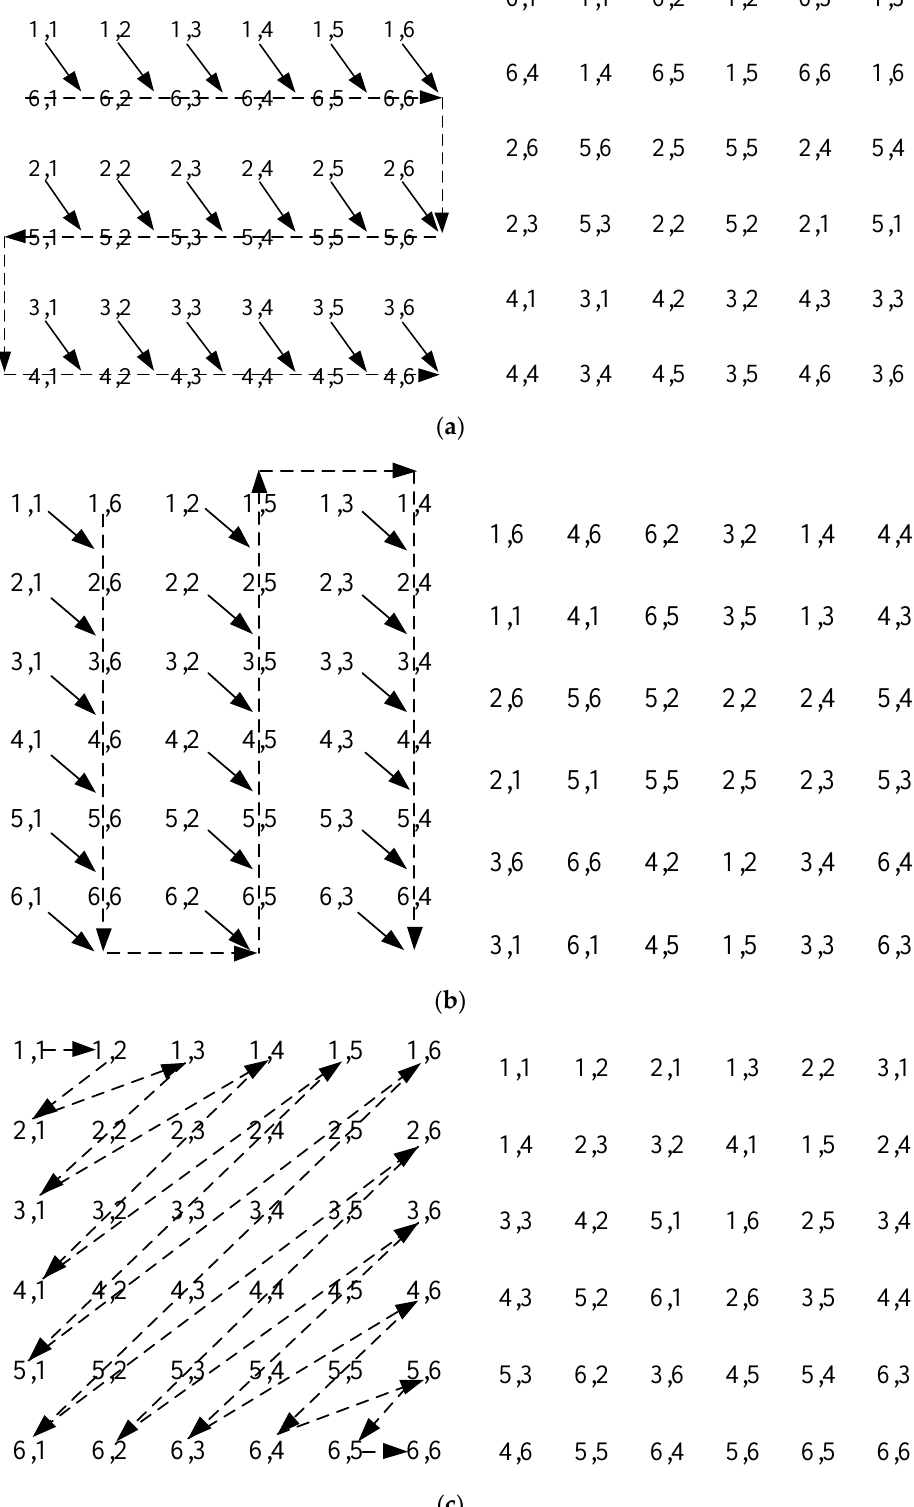
Figure 4. Process of the transform. ( a ) The stretch transform of nonadjacent rows; ( b ) The stretch transform of nonadjacent columns; ( c ) the fold transform of a snake line.